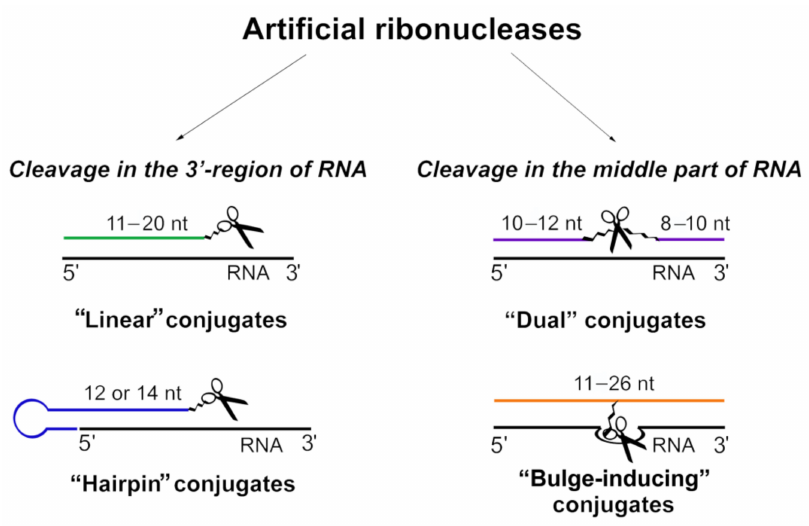
Figure 2. Schematic representation of duplexes of ss-aRNases of various design with RNA targets. Numbers show the length of RNA recognition motif complementary to target sequence within RNA. Scissors refer to a catalytic domain of